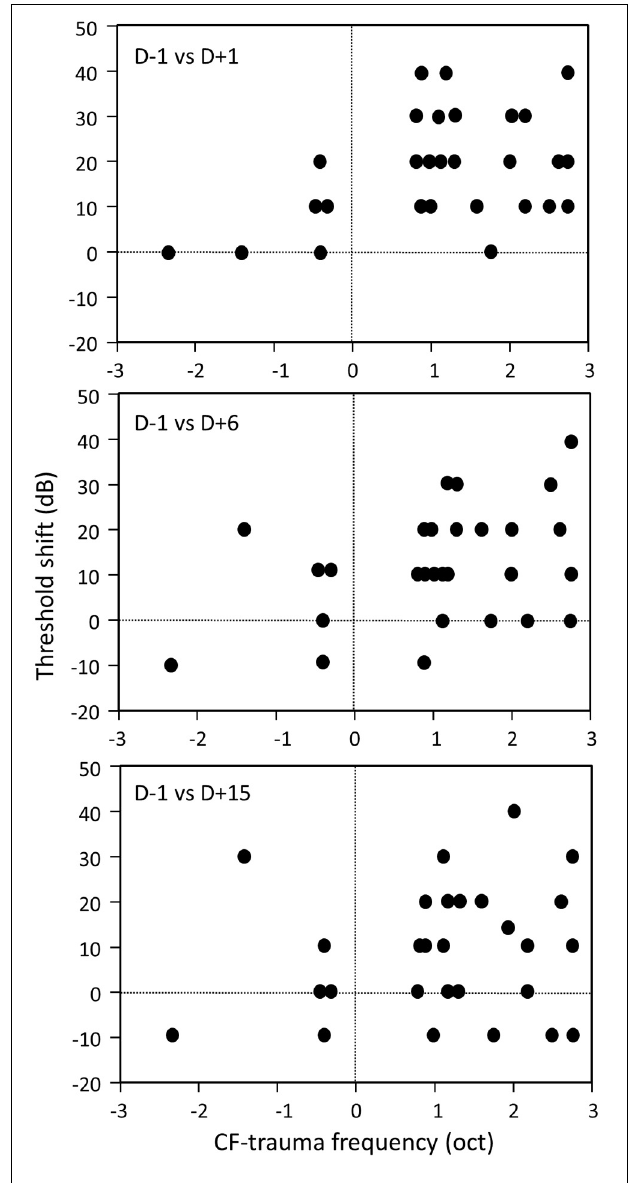
FIGURE 4 | Lack of correlation between ABR threshold shifts and CF distance from trauma frequency. Each scatterplot represents the ABR threshold shift as a function of the frequency shift (e.g., CF—trauma frequency) of each neuron 1 day (top), 3 days (middle), and 6 days (bottom) after the